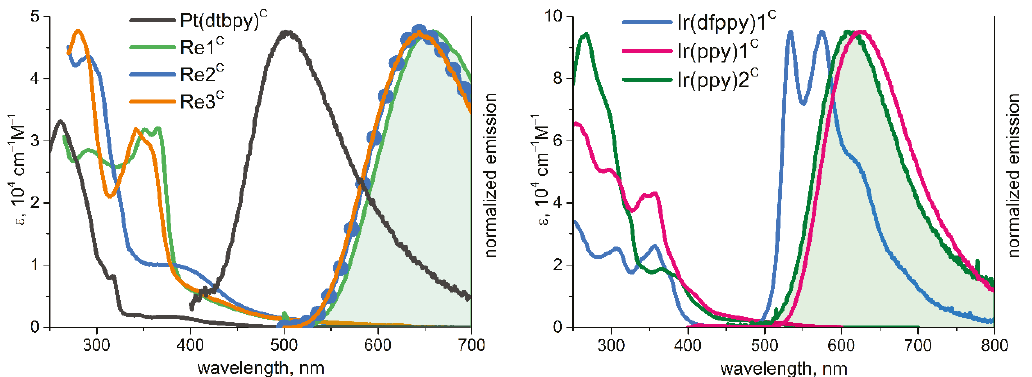
Figure 2. Absorption spectra and normalized emission ( λ ext 365 nm) spectra of Re(I), Pt(II), and Ir(III) “clicked” complexes, DCE solution, 10 − 5 M, r.t.